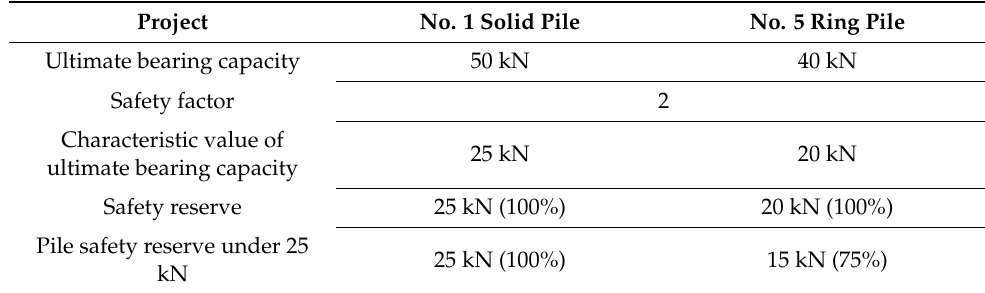
Table 3. Comparison of characteristic values of ultimate bearing